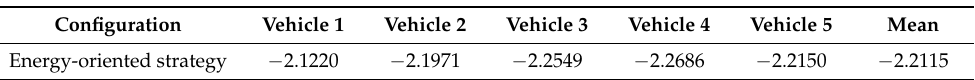
Figure 4. Energy-oriented scenario-tracking performances. Time history of: ( a ) vehicles longitudinal position p i ( t ) i = 0, . . . ,5; ( b ) vehicles speed v i ( t ) , i = 0, . . . ,5; ( c ) vehicles acceleration a i ( t ) , i = 0, . . . ,5; ( d ) inter-vehicle distances ˜ d i , i − 1 ( t ) , i = 1, . . . ,5; ( e ) comparison between inter-vehicle distances ¯ d i , i − 1 ( t ) and ˜ d i , i − 1 , i = 1, . . . ,5 in basic and energy-oriented scenarios. Table 2. Percentage of energy saving in (kWh/km) under energy-oriented architecture with respect to the basic